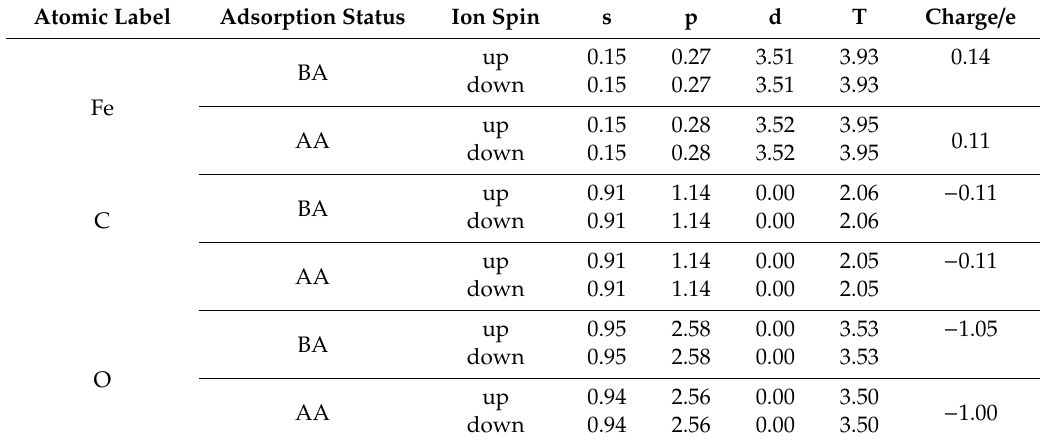
Table 7. Mulliken charge populations of atoms for H 2 O /